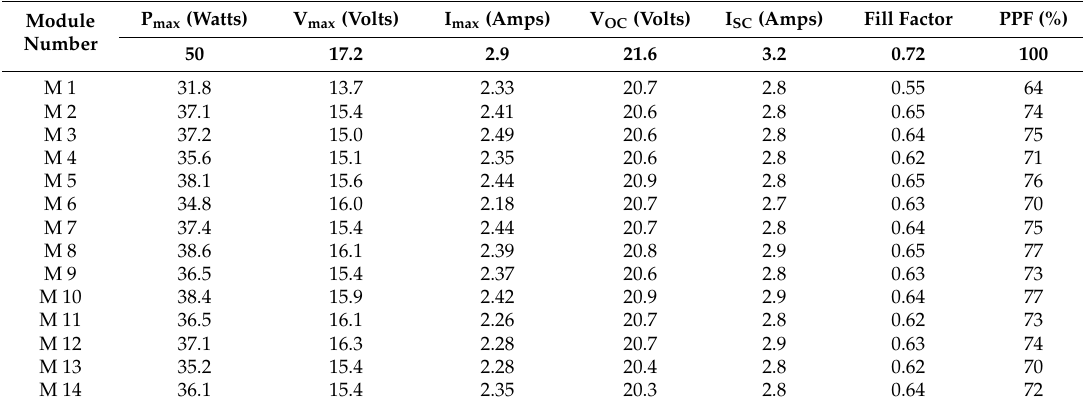
Table 3. Results of module performance parameters from I-V tests.